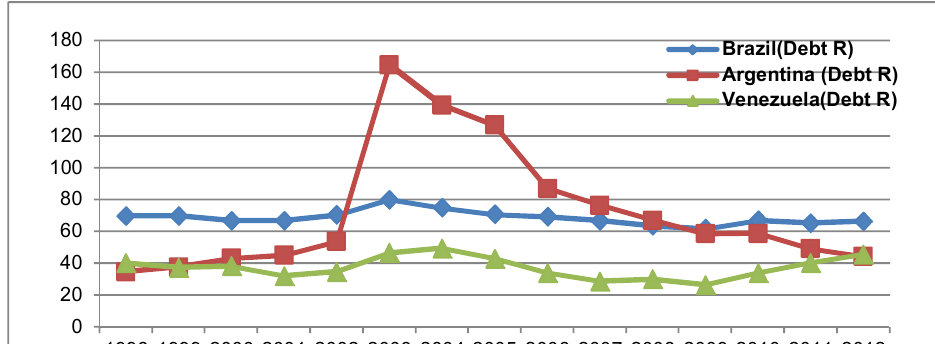
Figure 9: Trends of Debt to GDP Ratio of Countries